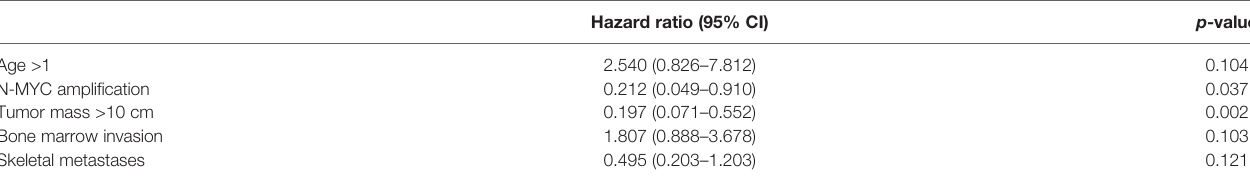
TABLE 7 | Multivariate analyses of prognostic factors for overall survival.